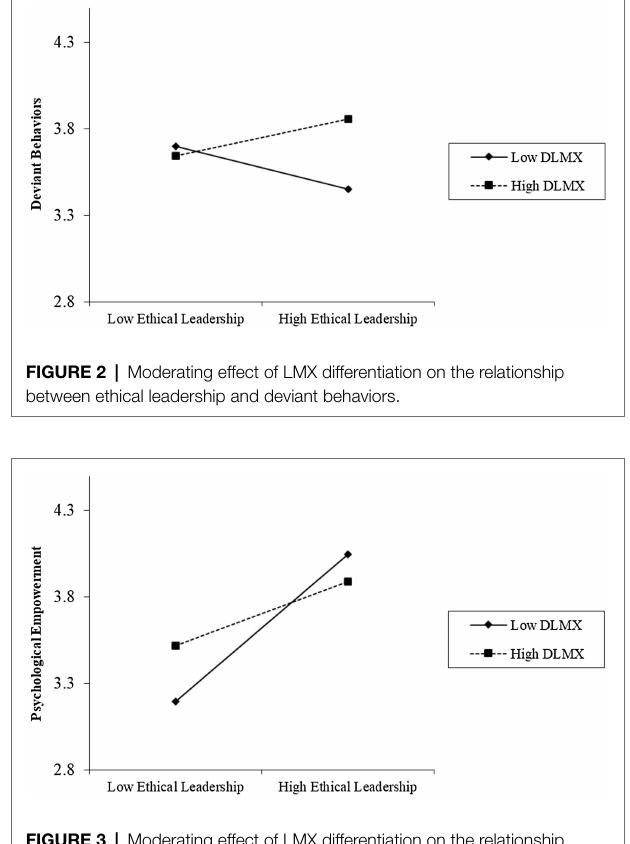
FIGURE 3 | Moderating effect of LMX differentiation on the relationship between ethical leadership and psychological empowerment.